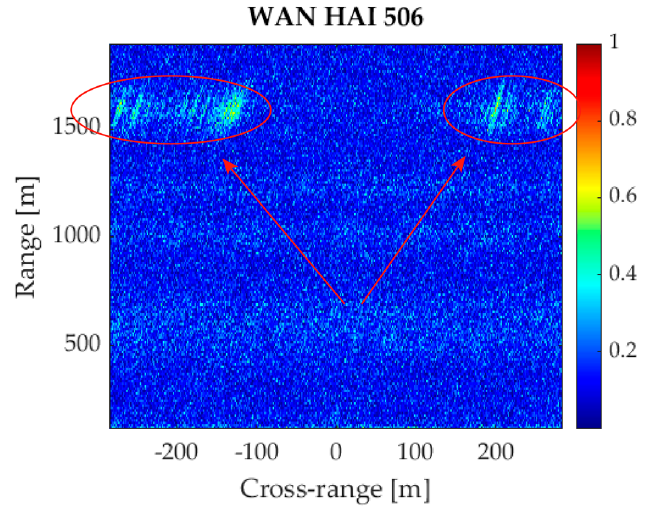
Figure 16. SAR image for WAN HAI 506 with wrong azimuth matched filter.